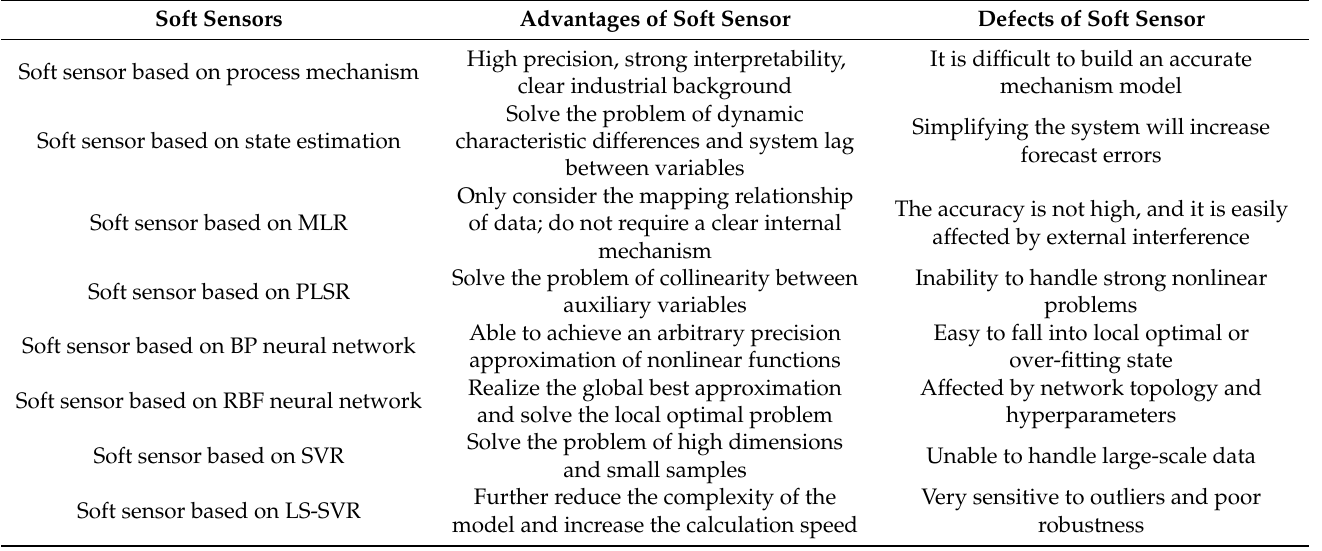
Table 1. Advantages and disadvantages of traditional soft